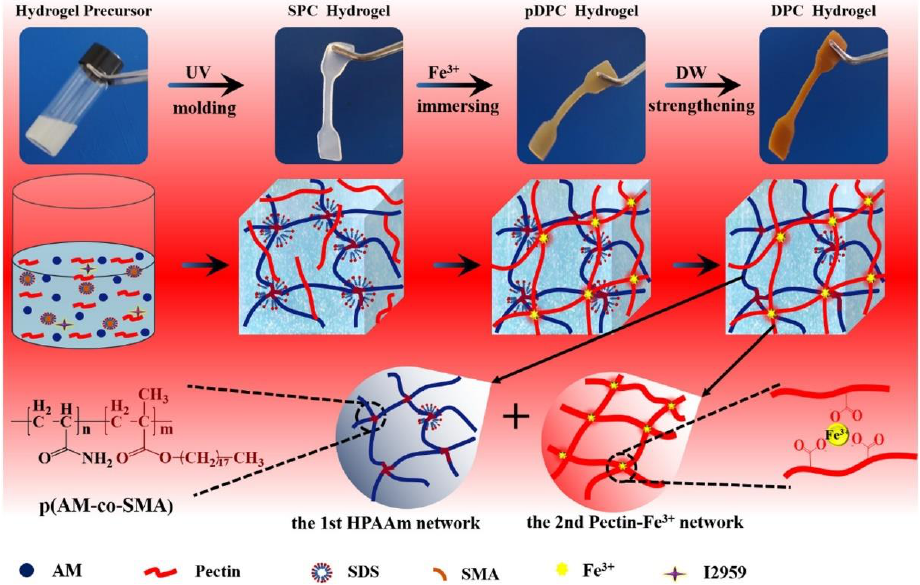
Figure 6. Dual physically crosslinked pectin-Fe 3 + ion / hydrophobically modified acrylamide hydrogels under ultraviolet light in three steps [74] .